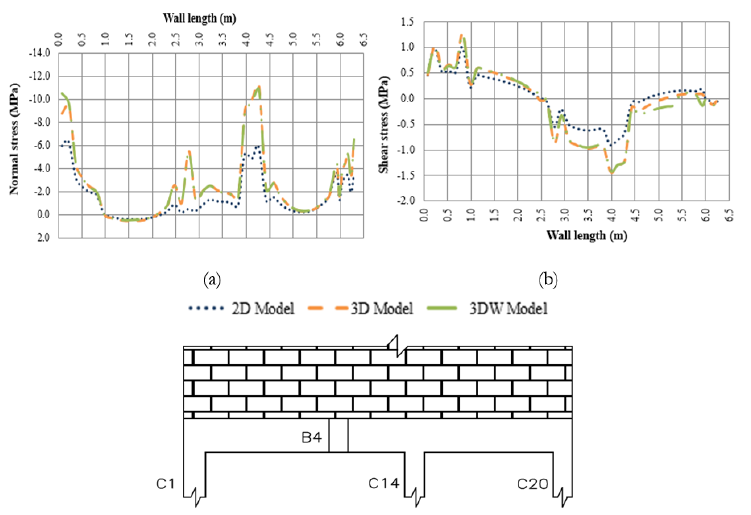
Figure 9. Stress distribution at the bottom of Wall 30: (a) Normal stress; (b) Shear stress.